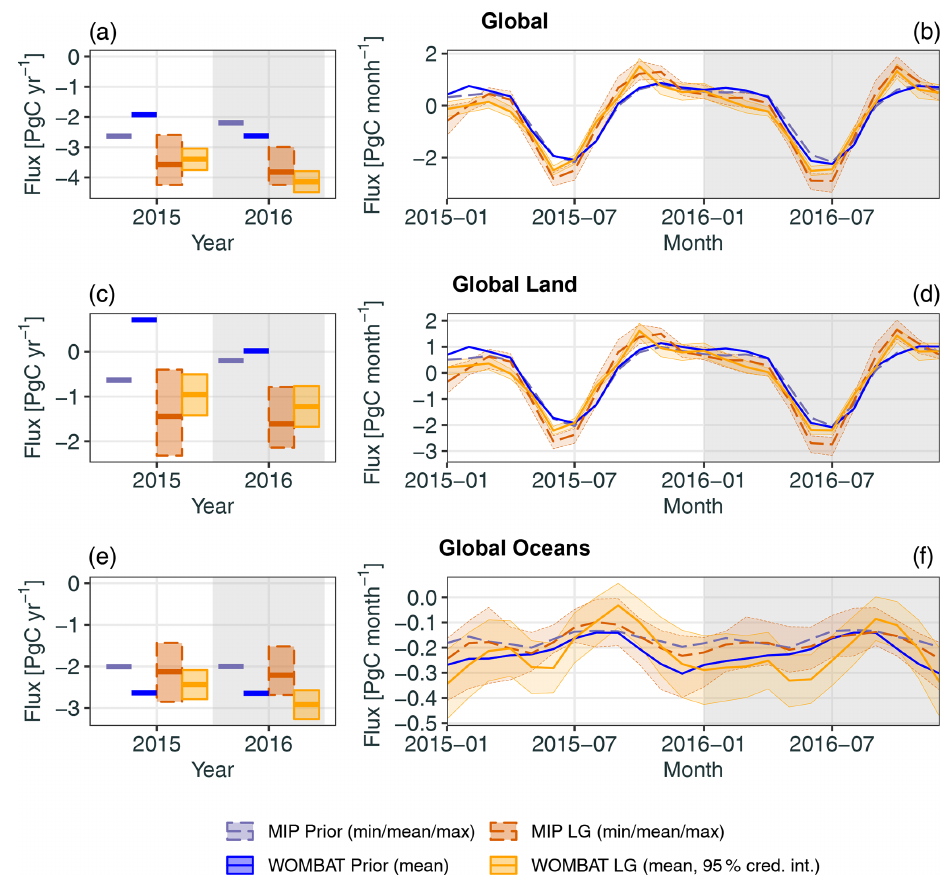
Figure 4. Annual (a, c, e) and monthly (b, d, f) fluxes for the globe (a, b) , land (c, d) , and ocean (e, f) . Summaries of flux estimates from the MIP and the flux estimate from WOMBAT are shown, split into the prior and LG inversions. Thick lines represent the ensemble means for the MIP and the (prior or posterior) means for WOMBAT. Shaded areas and thin lines for the MIP represent values between the ensemble minimum and maximum, while for WOMBAT they represent values in the 95% credible intervals (cred. int.). Fossil-fuel fluxes are excluded from all figures. Note that each row of plots has a different vertical